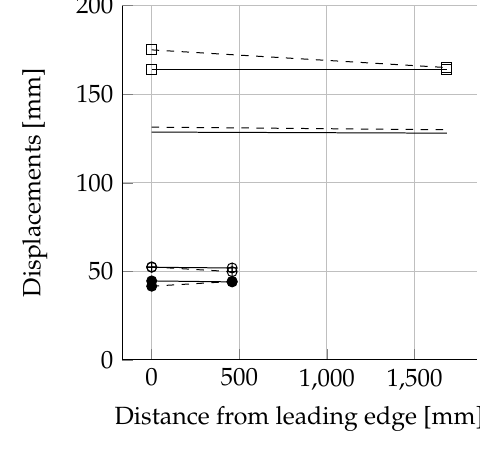
( b ) Displacements at position L = 9700mm.